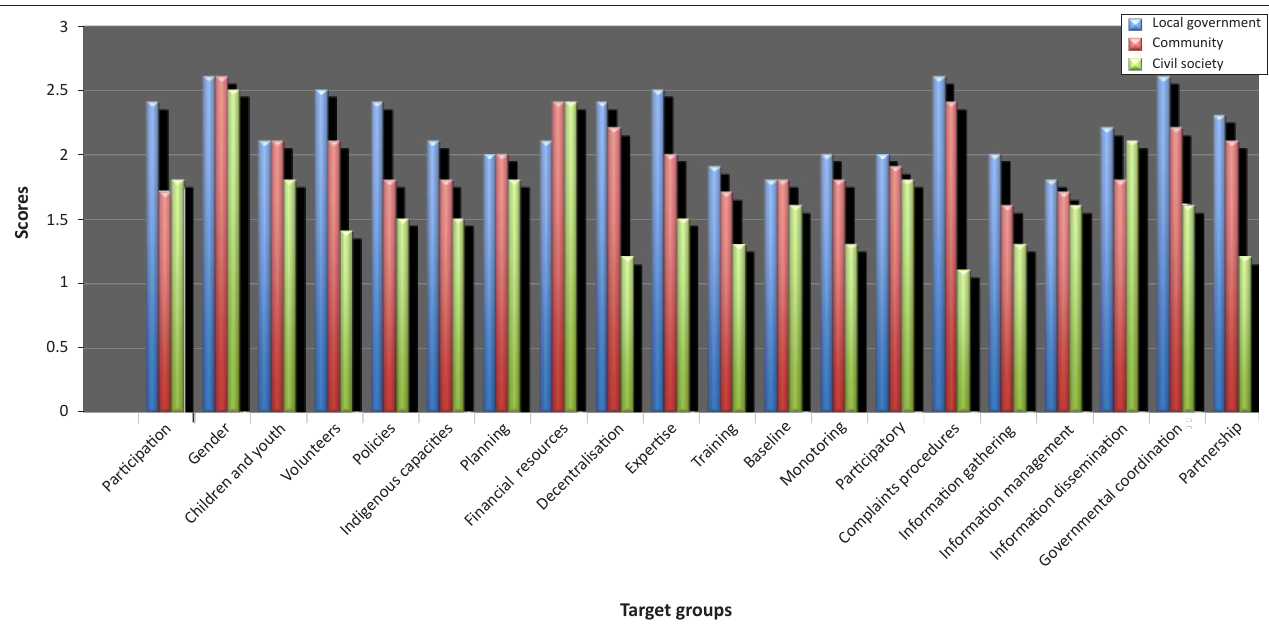
FIGURE 6: Mean scores for local risk governance according to the different target